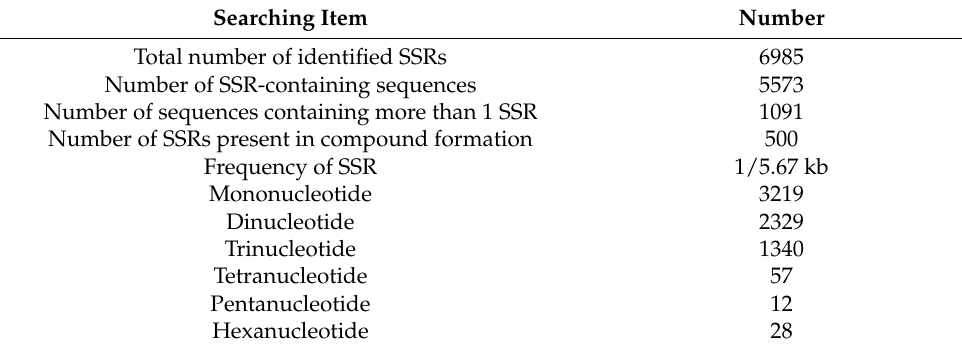
Table 4. Sequence searching for the SSR markers of C. macrophyllum .